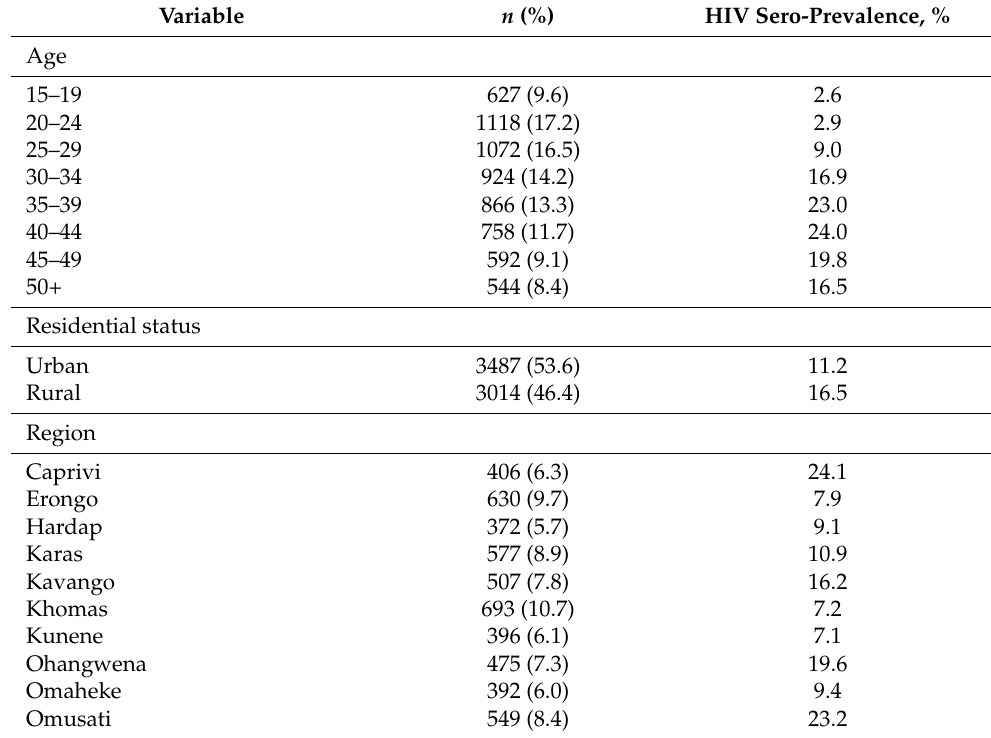
Table 2. Distribution of HIV prevalence across women’s characteristics in